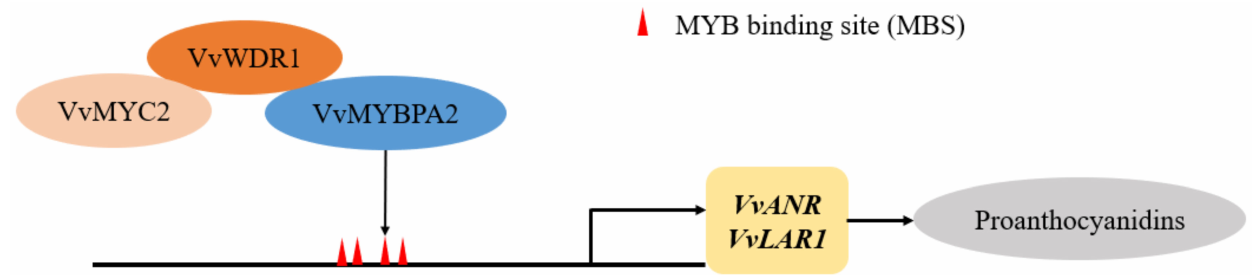
Figure 5. Prediction of the biosynthesis pattern of grape PAs regulated by MBW